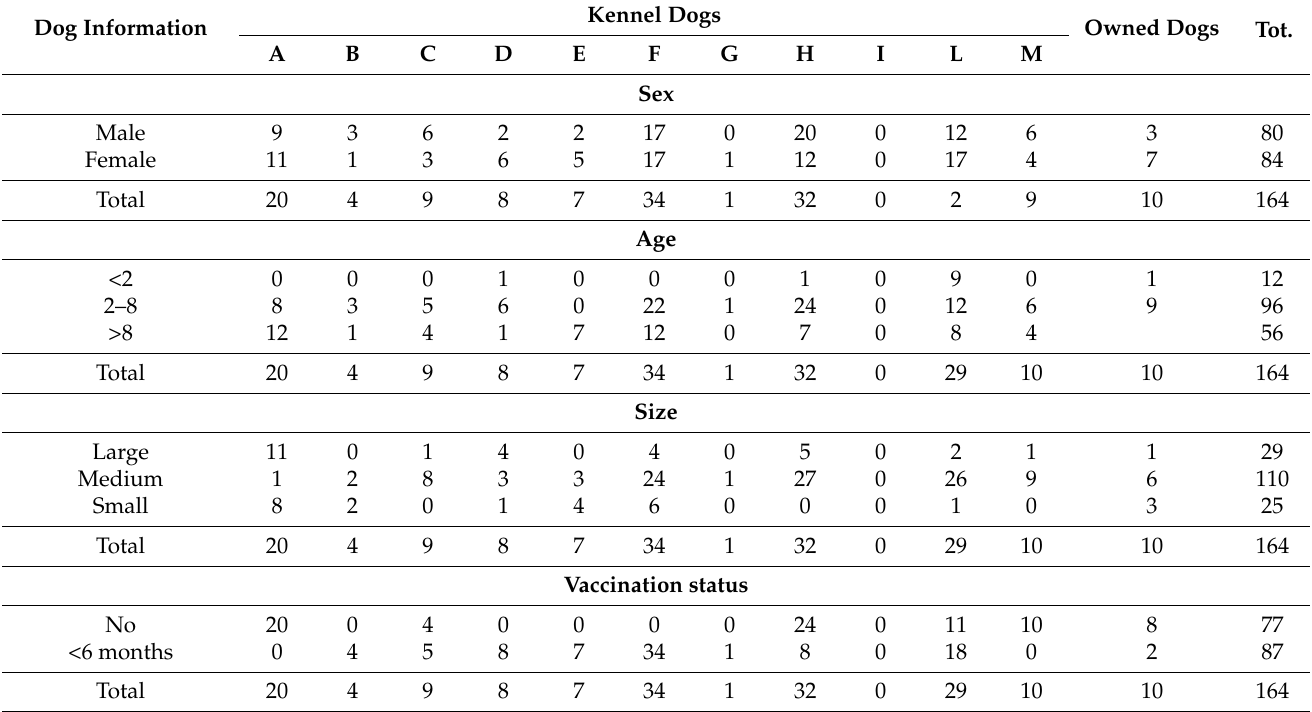
Table 4. Prevalence of positive MAT results in the dogs’ population divided by kennel location sex, age, size, and vaccination